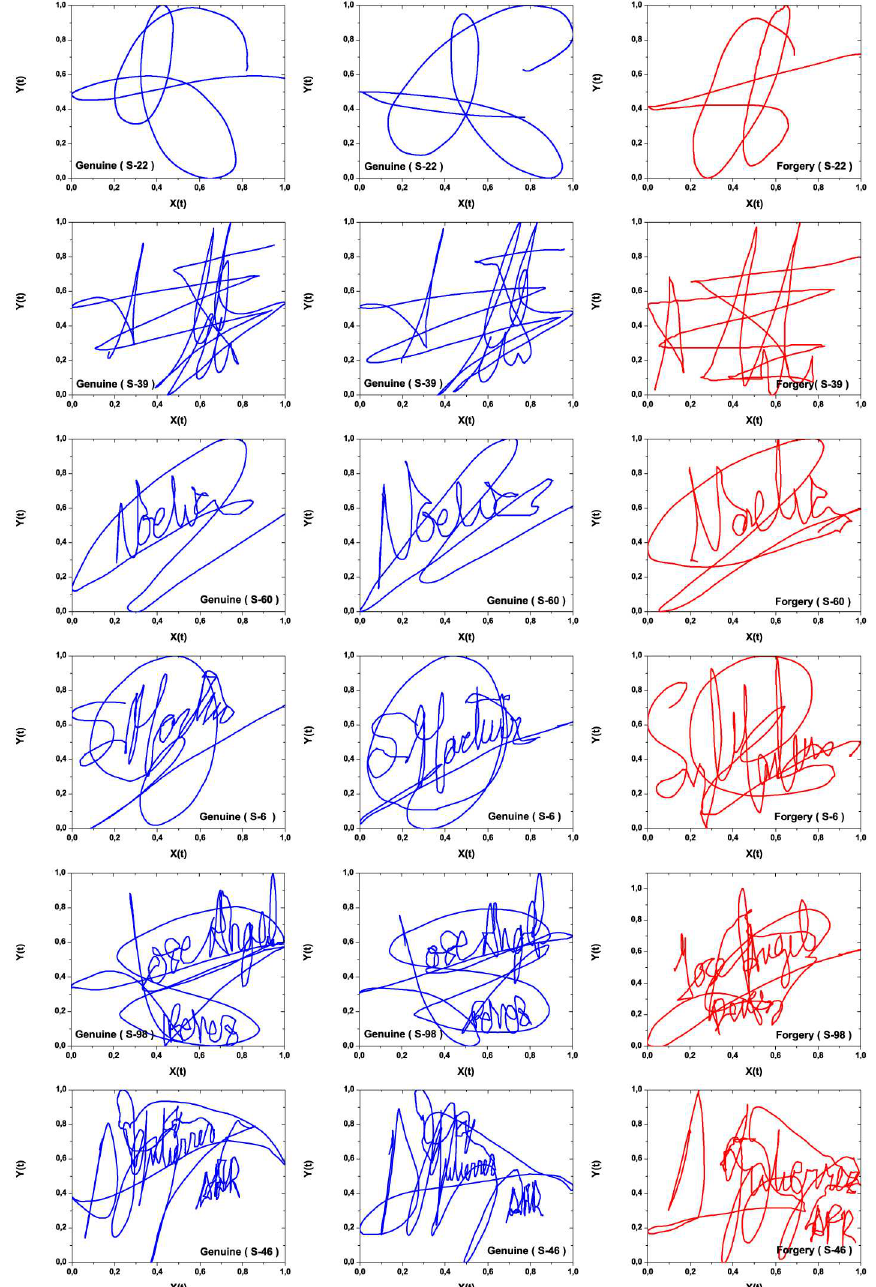
Fig 2. Six different subjects signatures from the MCYT database. Two genuinesignatures (left, blue) and a skilledforgery (right, red). The two first signatures were classified as H1A and H1B, the followingtwo to types H2A and H2B, and the last two to types H3A and H3B; cf. Sec. Signature classification.